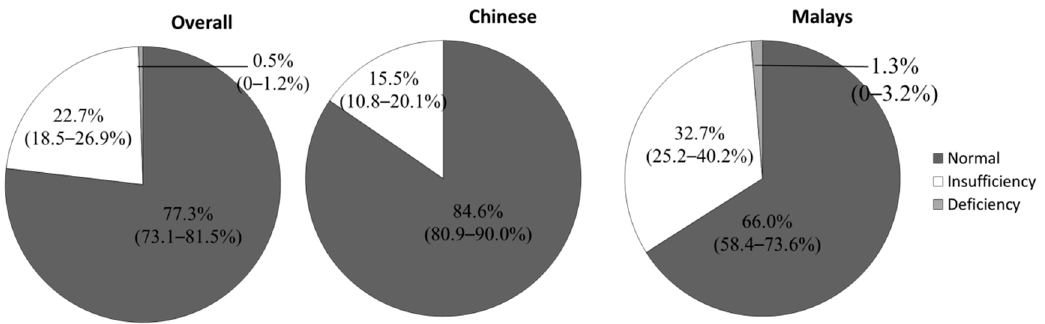
Figure 3. Vitamin status of Malaysian men.